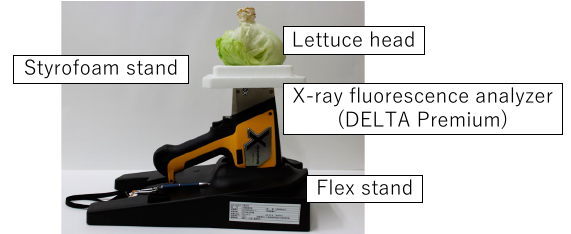
Fig. 4: Measurement method using XRF FFiigg.. 44 MMeeaassuurreemmeenntt mmeetthhoodd uussiinngg XRF mmeetthhoodd 677